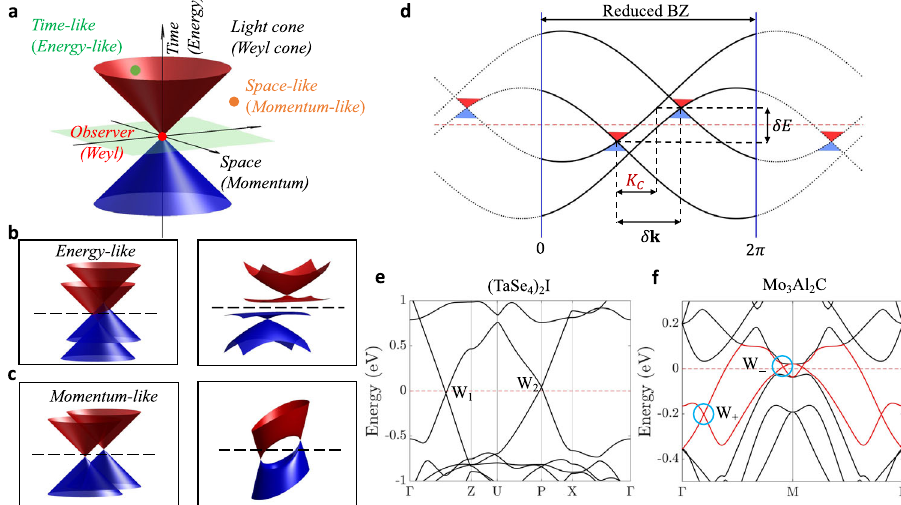
Fig. 2 | Causal structure in energy-momentum space and its applications. a In analogy with the theory of relativity, we de fi ne the region in energy-momentum spacewithin/outside the Weyl cone as the energy-like/momentum-like region. b In the leftpanel,twoWeylnodesareenergy-like in thereduced BZ.Inthe rightpanel, including interaction, the system undergoes a semimetal-insulator phase transi- tion. c In the left panel, two Weyl nodes are momentum-like in the reduced BZ. In therightpanel,includinginteraction,thesystemremainsinasemimetalphase. a – c The red/blue structures represent the conduction/valence dispersion cones. The